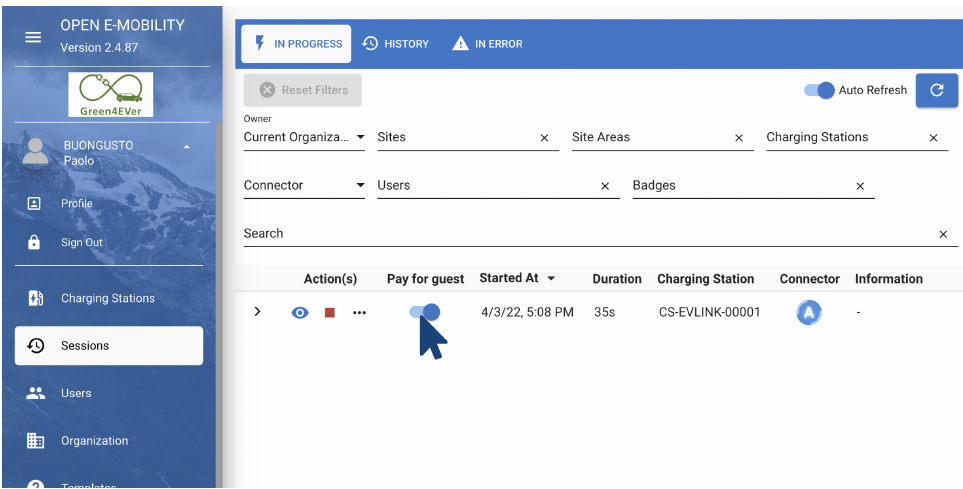
Figure 5. Example screenshot for adding charging points to an existing pool.